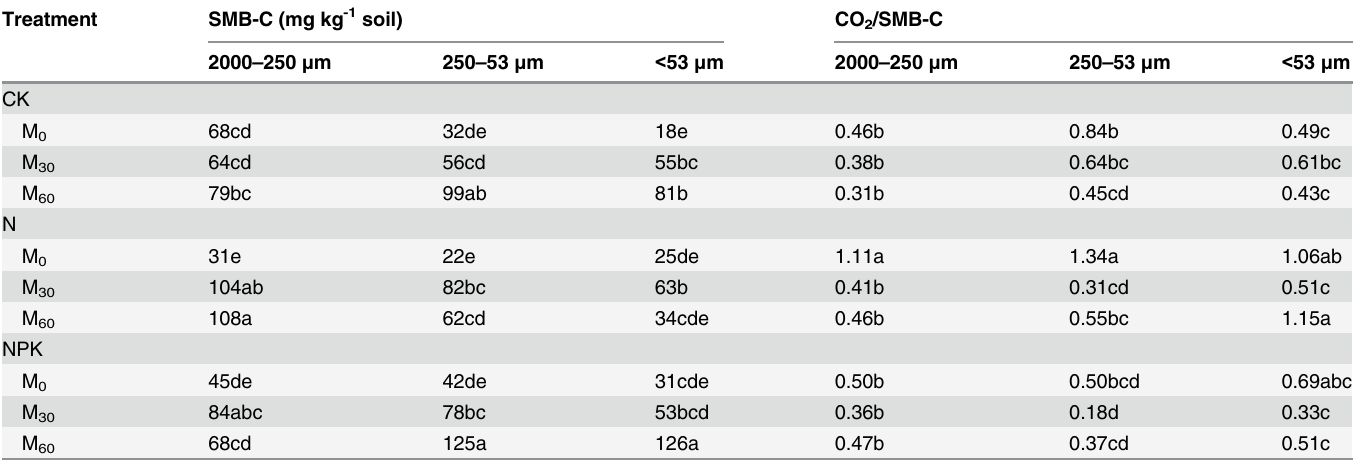
Table 3. Soil microbial biomass carbon(SMB-C) and CO 2 /SMB-C (qCO 2 ) in different particle-size fractions from the control (CK) or soil that received 32 years of chemical fertilizer application (N: nitrogen, P: phosphorus, K: potassium) and either 0 (M 0 ), 30(M 30 ) and 60 (M 60 ) t manure ha -1 yr -1 .